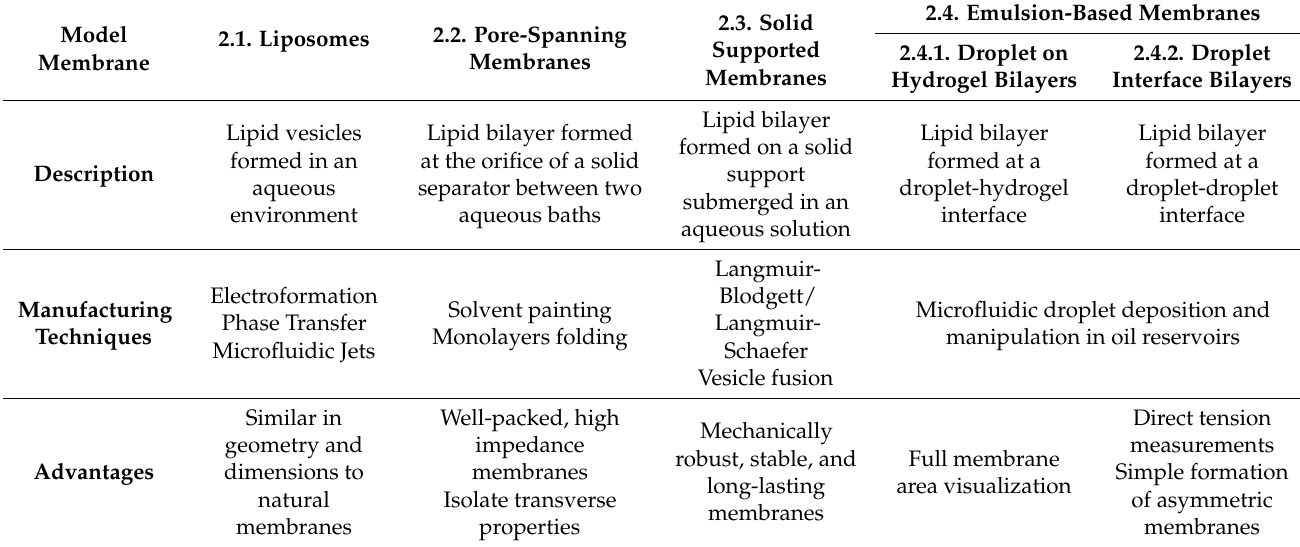
Table 1. Summary of the discussed model membrane manufactures.